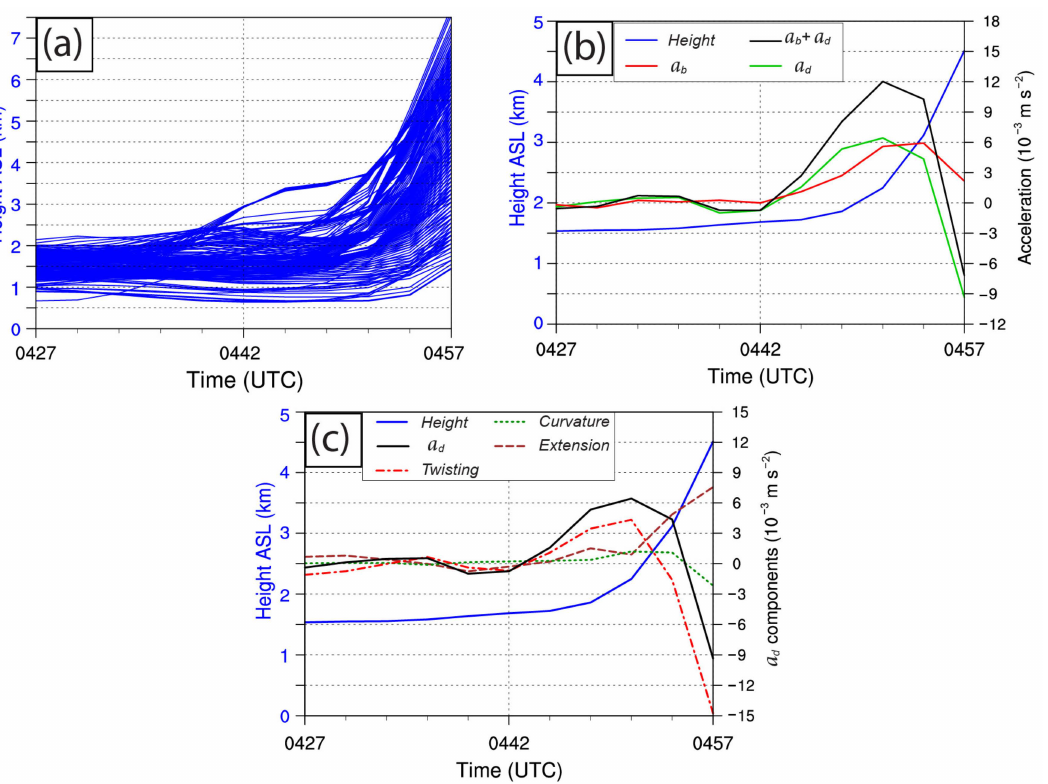
Figure 11. ( a ) Height along the backward trajectories of air parcels with vertical velocities in the top 25% quantile at the CI time (i.e., 0457 UTC) within the selected convective cell in 30 min before CI; ( b ) Averaged height and vertical momentum components induced by dynamic force ( a d ), buoyancy ( a b ), and sum of them ( a d + a b ) along the air parcels selected within the convective cell in 30 min before CI; ( c ) Averaged height, dynamic acceleration ( a d ), and its three components ( Curvature , Twisting and Extension ) in 30 min before